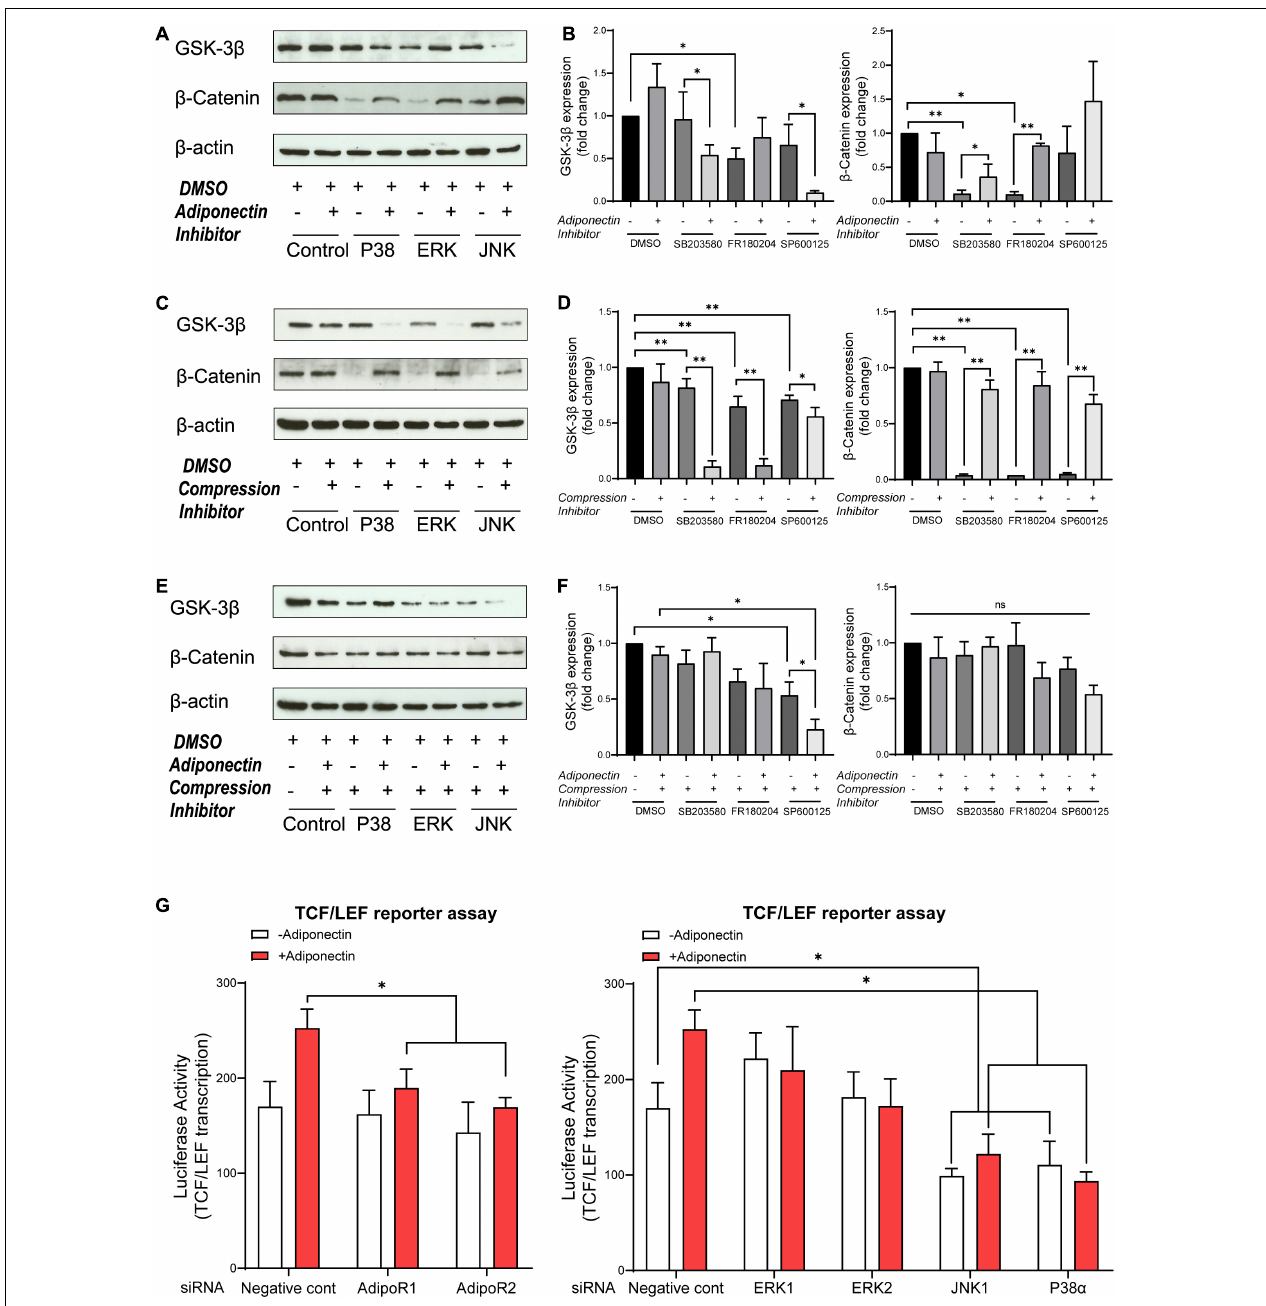
FIGURE 4 | MAPK inhibition blocks β -catenin, whereas adiponectin addition effectively rescues its expression. (A,B) Western blots indicate that GSK-3 β expression was influenced by MAPK inhibitors 1 h after adiponectin addition: pictures show that addition of SB203580 (P38) and SP600125 (JNK) inhibitors to OCCM-30 cells up-regulate GSK-3 β protein expression. The expression of β -catenin was reduced after P38 and ERK1/2 inhibition. The suppressed β -catenin signaling could be rescued by adiponectin (100 ng/ml) in different degrees. (C,D) Compressive forces of 2.4 gf/cm 2 decrease the expression of total GSK-3 β protein in cells pretreated with SB203580 (P38), SP600125 (JNK), and FR180204 (ERK1/2) inhibitors and increase the expression of cellular β -catenin. Single suppression of P38, ERK, and JNK blocks β -catenin, but its expression was rescued by compression stimulation. (E,F) The negative effect that ERK1/2 and JNK inhibition exerts on the expression of total GSK-3 β protein on OCCM-30 cells exposed to compression is not altered by adiponectin addition for 1 h of co-stimulation. P38 inhibitor combined with compression decreases the expression of GSK-3 β . This effect was enhanced by adiponectin addition. The expression of β -catenin was not significantly altered in the presence of MAPK inhibitors and compression despite adiponectin. Graphics show the variations of GSK-3 β and β -catenin protein expression as fold change when cells were exposed to MAPK inhibitors in cells cultivated under compressive forces (2.4 gf/cm 2 ) and/or adiponectin (100 ng/ml) compared to controls. (G) OCCM-30 transfected with siRNA ( AdipoR1 , AdipoR2 , P38 α , JNK1 , ERK1 , and ERK2 ) as well as TCF/LEF luciferase reporter vector were subsequently treated with adiponectin for 1 h. Asterisks indicate statistical significance ( ∗∗∗ p < 0.001, ∗∗ p < 0.01, and ∗ p < 0.05; ns, not significant).